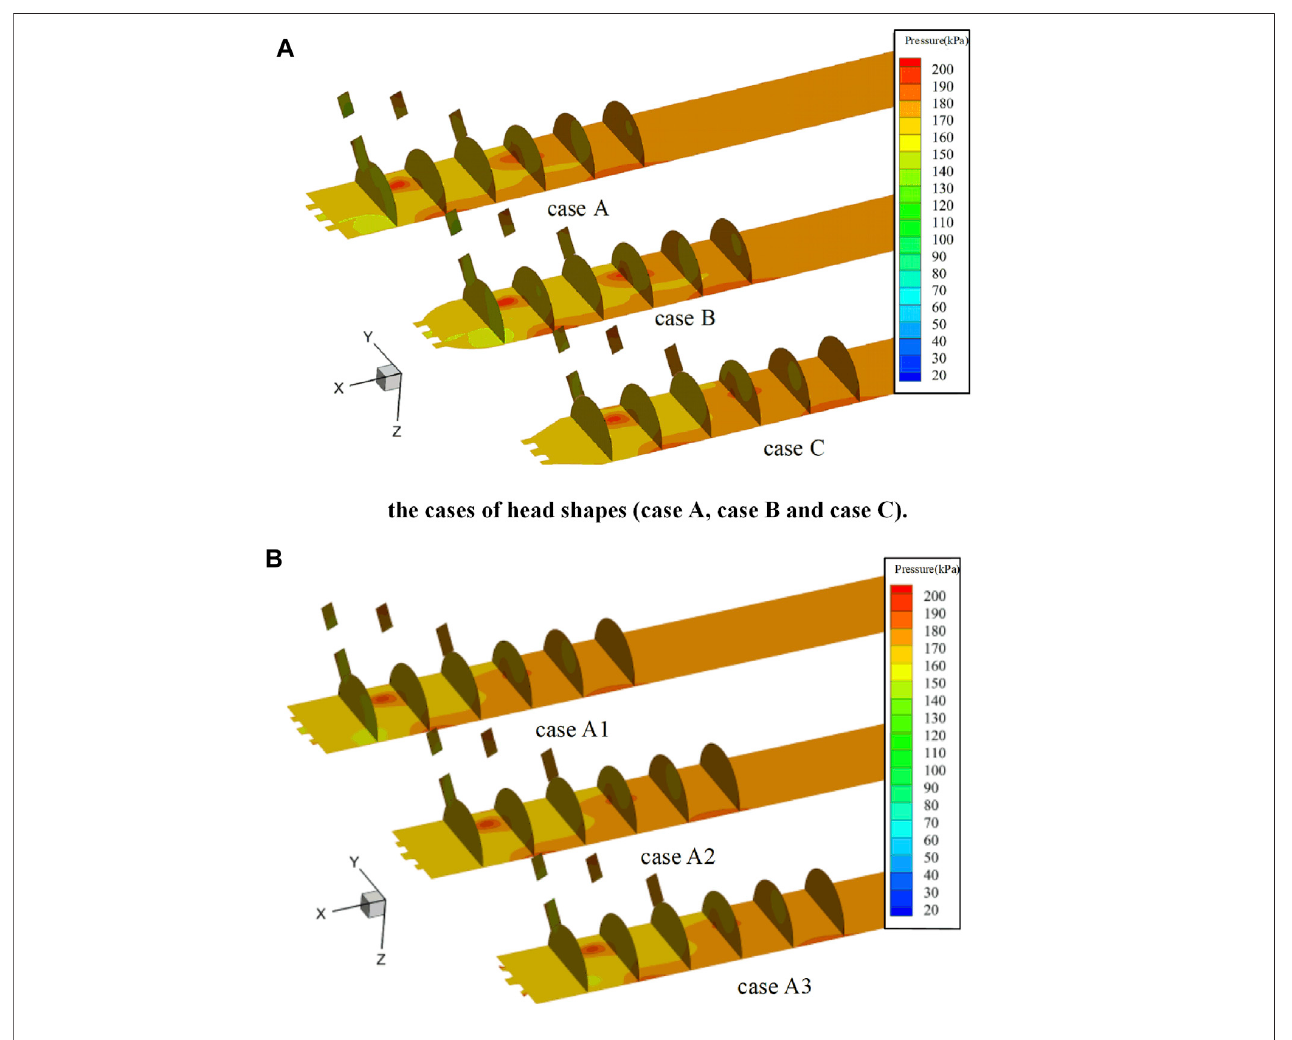
FIGURE 10 | Pressure distributions on the x-y central sections and six y-z sections along the streamwise direction for all the cases: (a) the cases of head shapes (case A, case B, and case C); (b) the cases of different inlet patterns (case A1, case A2, and case A3).